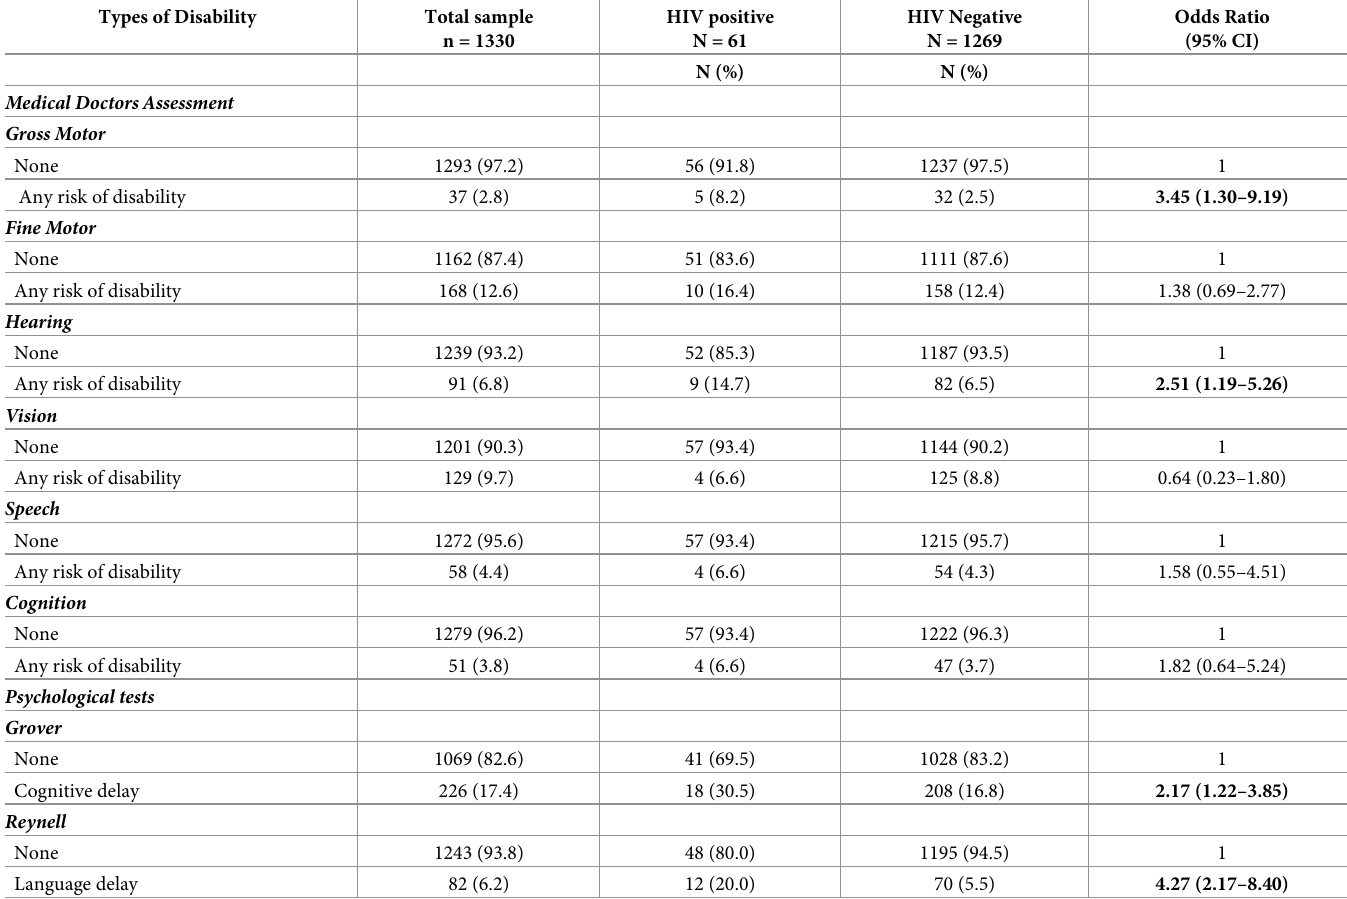
Table 4. Types of disability assessment comparing any risk of disability (mild/moderate/severe/uncertain) to no disability by HIV